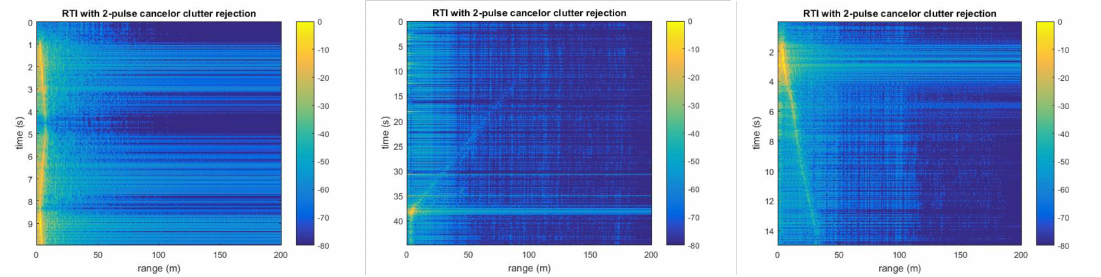
Figure 8. Ranging test results using version zero radar